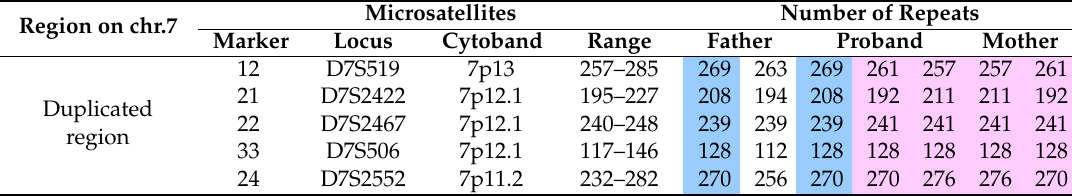
Table 2. Segregation pattern of informative microsatellite markers in the duplicated 7p13-p11.2 region. Paternal alleles are presented with a light blue background; maternal alleles are presented with a pink background. Region on